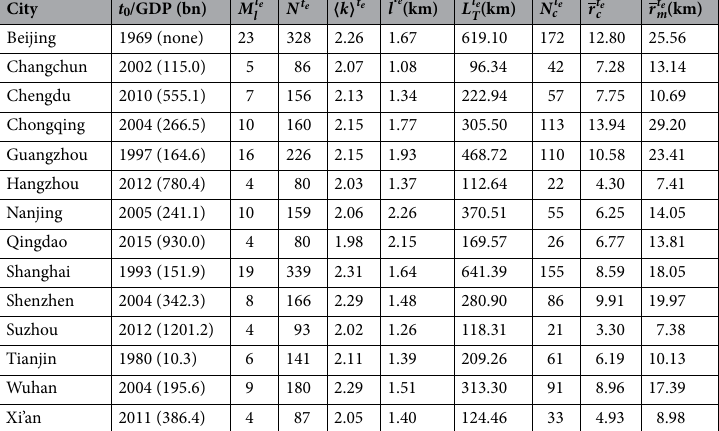
Table 1. The summary of network indicators considered in this article is arranged according to the alphabet of city names. t 0 is the initial operation of the metro with the GDP of the city in that year. The other eight t e measures are the topological indicators for the metro network in 2019 ( t e ) including M l (the number of lines), N t e (the network size), (cid:31) k (cid:30) t e (the average value of the nodal degree), l t e (the average interstation distance), L t e T t e r t e (the total route length), N c (the number of nodes in the core), c (the average distance from the barycenter to t e the boundary of the core) and r m (the average distance from the barycenter to the network